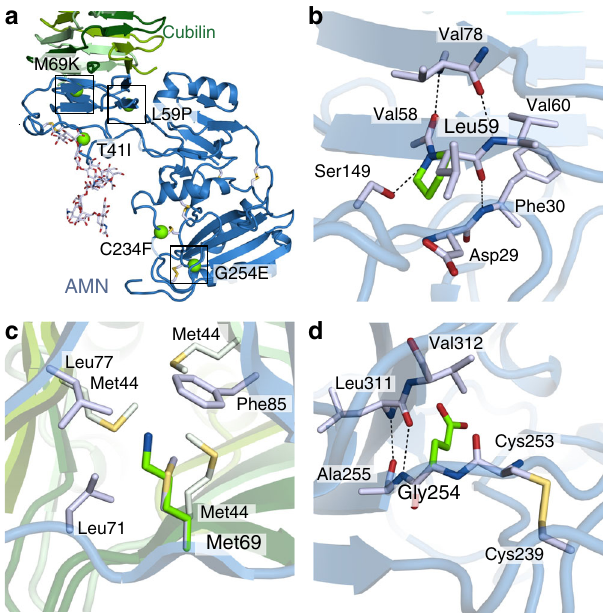
Fig. 6 Missense mutations of AMN causing Imerslund – Gräsbeck syndrome. a AMN missense mutations causing Imerslund – Gräsbeck syndrome are marked by green spheres on a cartoon representation of the ectoAMN – cubilin structure. b – d Close-up views of AMN Leu59, Met69 and Gly254. The mutations are modelled using the rotamers with least clashes and shown as green sticks. Hydrogen bonds and ionic interactions are marked by dashed black lines